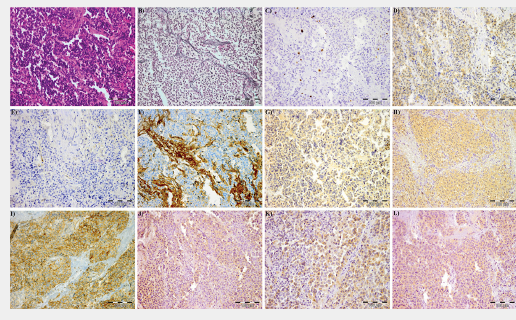
Figure 1 Immunohistochemical expression of the different markers‘ expression in a pituitary adenoma: (A) hematoxilin-eosin, (B) reticulin, (C) MIB-1 (Ki-67), (D) Eg5, (E) VEGFR-2, (F) vWF, (G) IL-8, (H) SSTR-1, (I) SSTR-2, (J) SSTR-3, (K) SSTR-4, (L) SSTR-5. Eg5 = kinesin spindle protein; IL-8 = interleukin-8; SSTR = somatostatin receptor; VEGFR-2 = vascular endothelial growth factor receptor-2; vWF = von